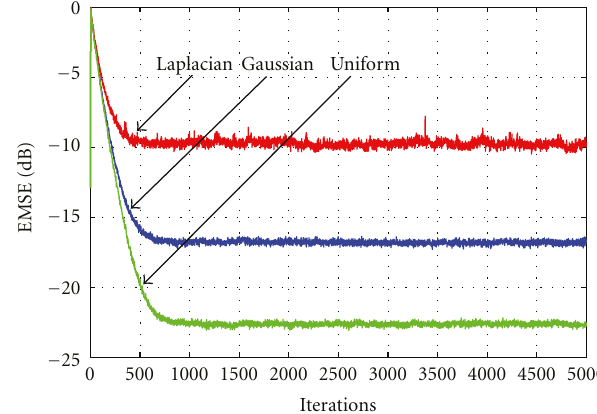
Figure 5: Learning curves of the proposed algorithm in di ff erent noise environments scenarios for α = 0 . 2 and SNR of 0